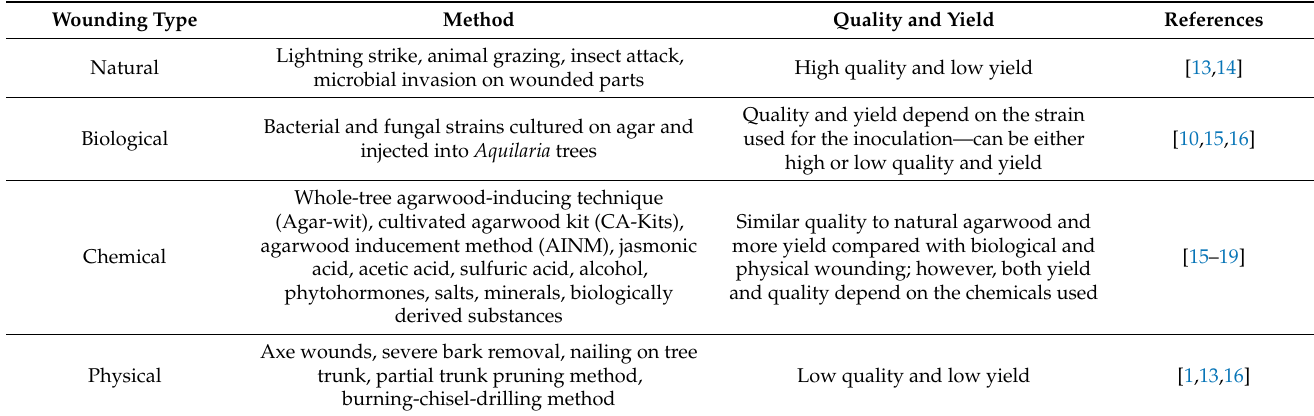
Table 1. Types of wounds inflicted on Aquilaria trees and the method to inflict these wounds for agar- wood production. The quality and yield of agarwood are dependent on the method of wound